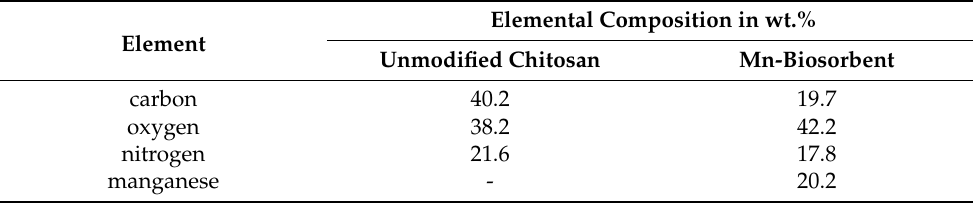
Table 1. The element content in the unmodified chitosan and Mn-biosorbent bead determined by the EDS